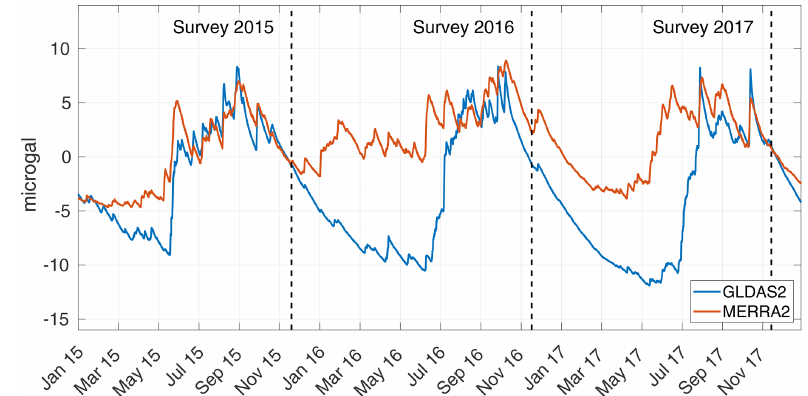
Figure 5. Hydrological effect on gravity at AG06, estimated from global hydrological models GLDAS2 and MERRA2.